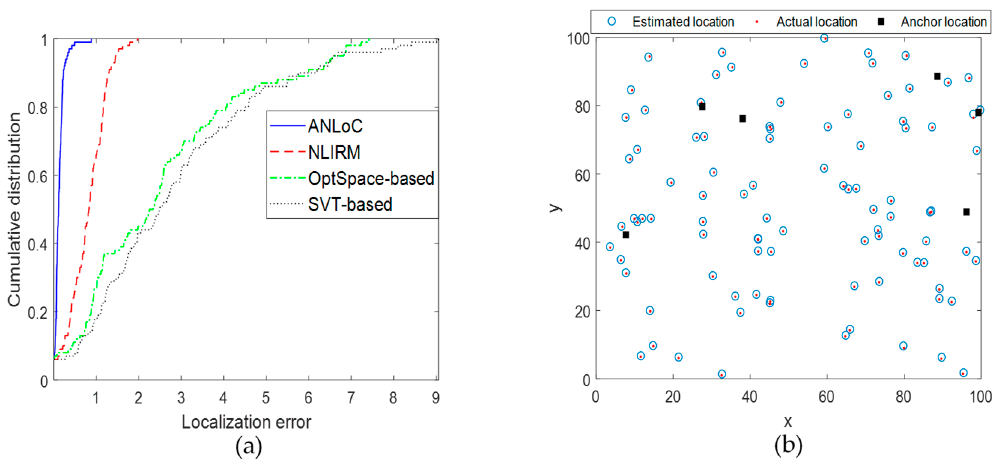
Figure 7. Illustration of localization performance under scenario 4 with both complex noise and anomaly. ( a ) Cumulative distribution of localization error and ( b ) positioning result display.